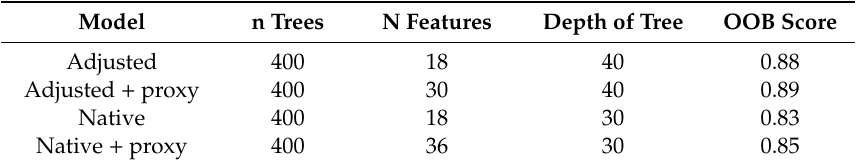
Figure 5. Evolution of the OOB score for different configuration models. Table 1. Optimized hyper-parameters for the discharge forecasting models and their OOB score at the training phase.